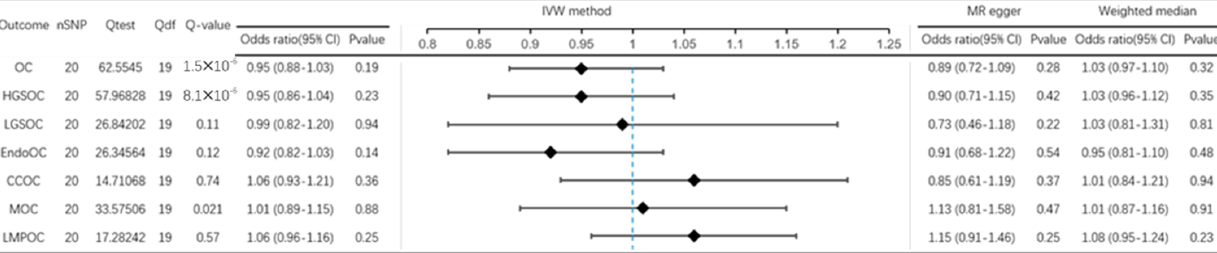
Figure 3. MR analysis results from PD to OC risk. IVW method, MR egger and weighted median method estimate for the association of PD with risk of OC (including its common subtypes).